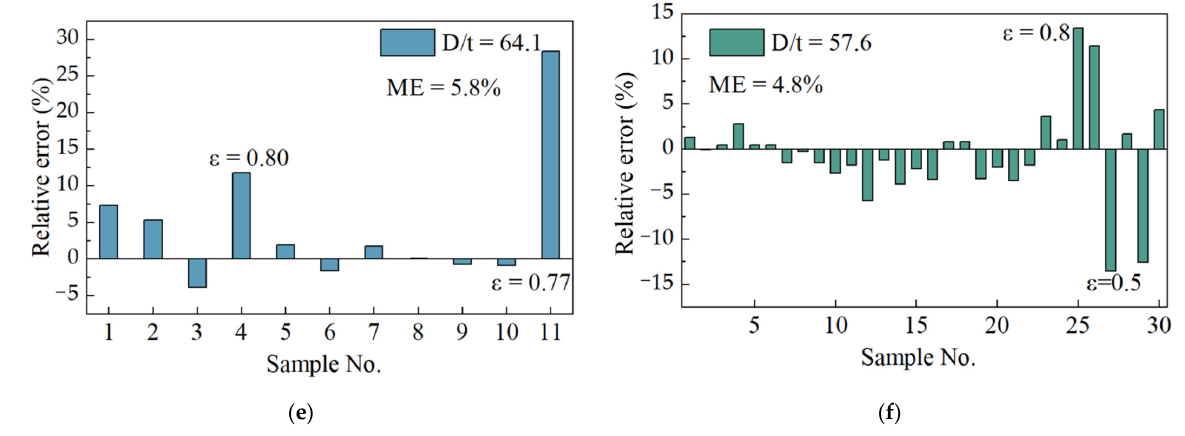
Figure 7. Errors between predictions and experiments at different corrosion rate.